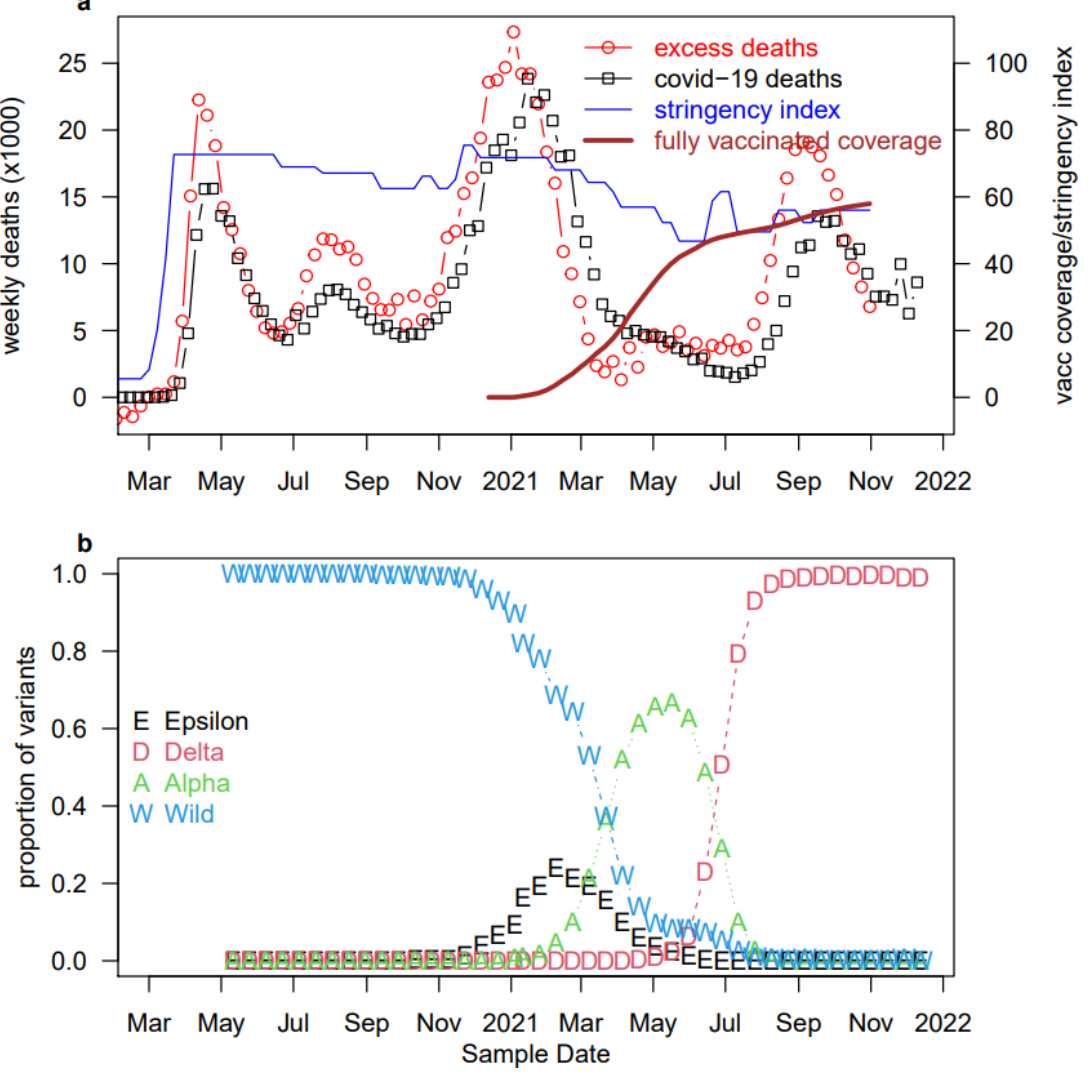
Figure 1. COVID-19 deaths [7,8], stringency index, vaccine coverage [9], and variant proportions [10–13] in the US. ( a ) Red empty circles (and black squares) represent the weekly excess deaths (and reported COVID-19 deaths) in the US. Excess deaths well match reported deaths, showing the high quality of death data. The red bold curve represents the percentage of fully vaccinated individuals, and the blue thin curve represents the stringency index which is a measure of control measure and population compliance. ( b ) Biweekly reported proportions of samples sequenced in the US. Overall, the Alpha variant replaced the wild strain, and subsequently, the Delta variant replaced the Alpha variant.